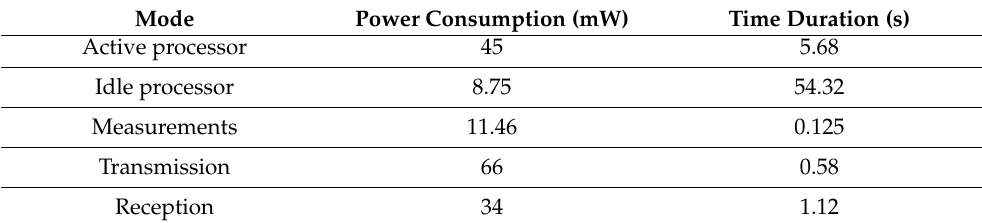
Table 8. Power consumption and Time duration of active